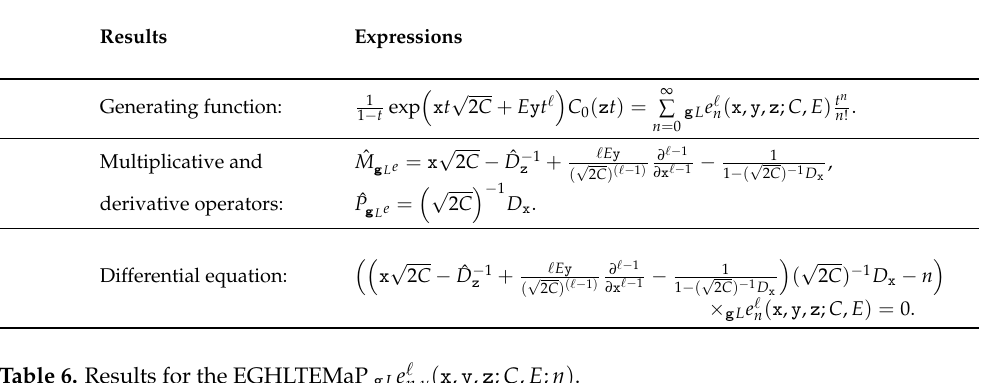
Table 6. Results for the EGHLTEMaP g L e (cid:96) n , ν ( x , y , z ; C , E ; η ) .